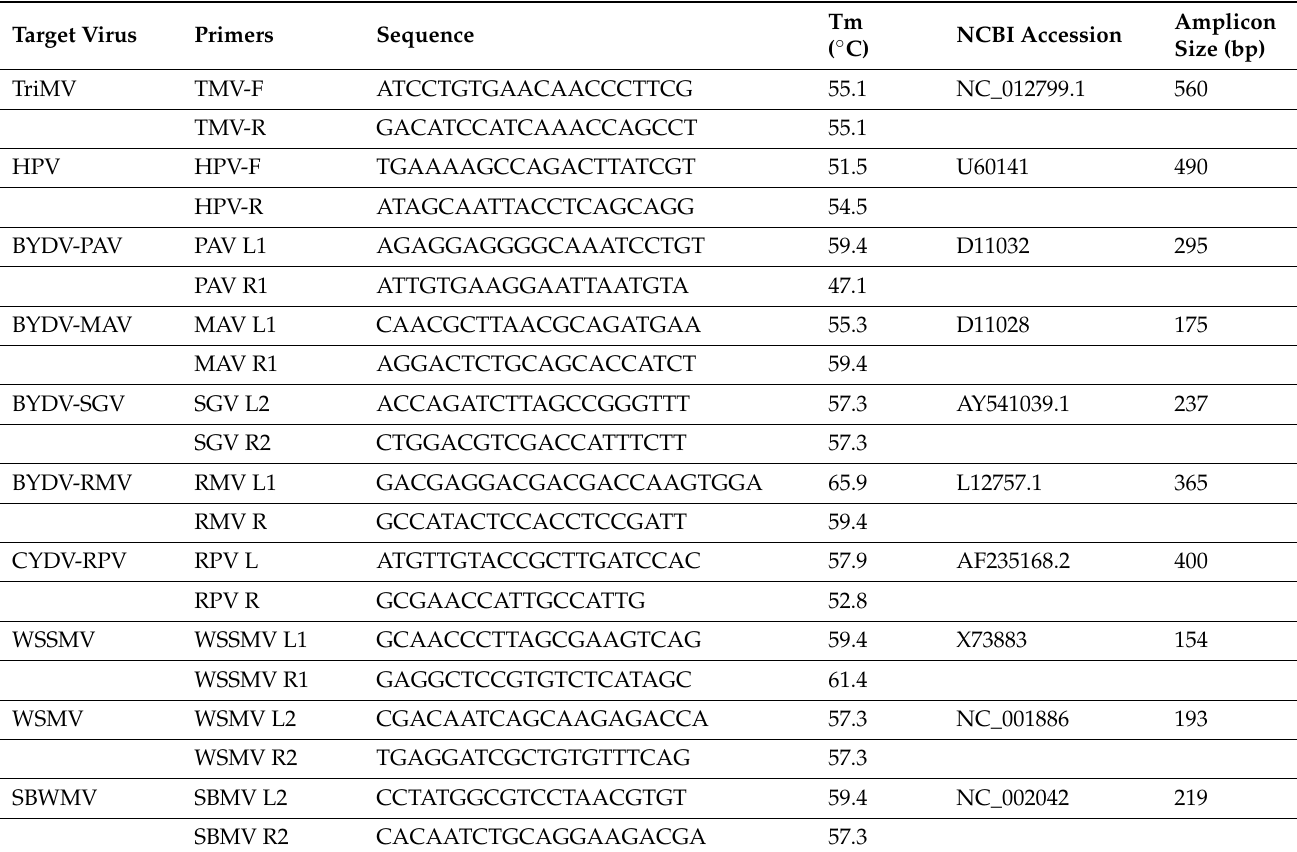
Table 1. Primers specific to each virus in the multiplex detection